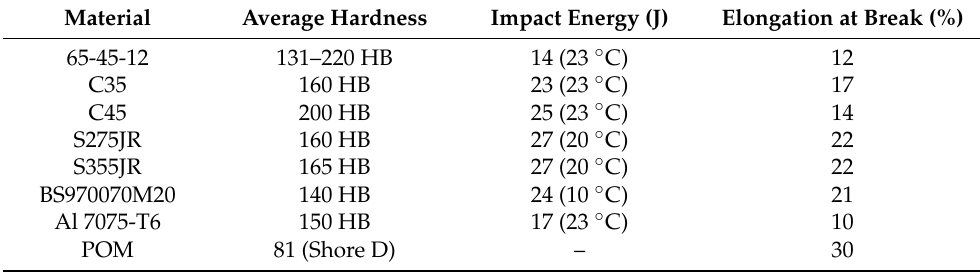
Table 4. Additional properties of the materials used for pistons.